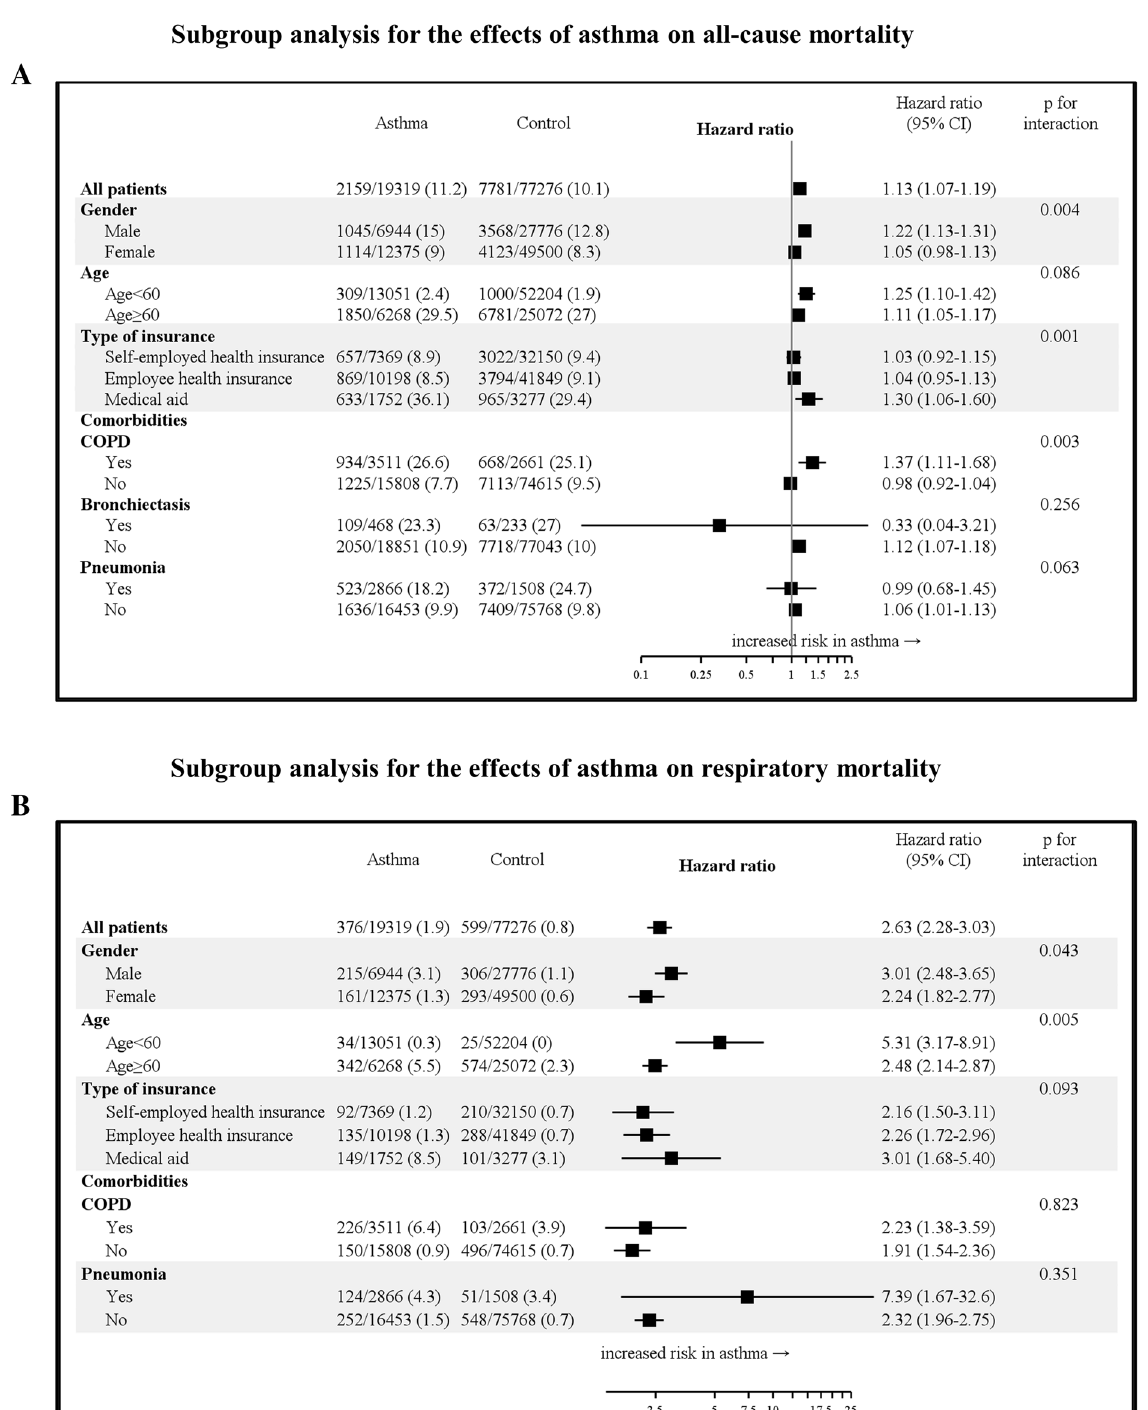
Figure 2. Subgroup analysis for the effects of asthma on mortality. ( A ) all-cause mortality, ( B ) respiratory